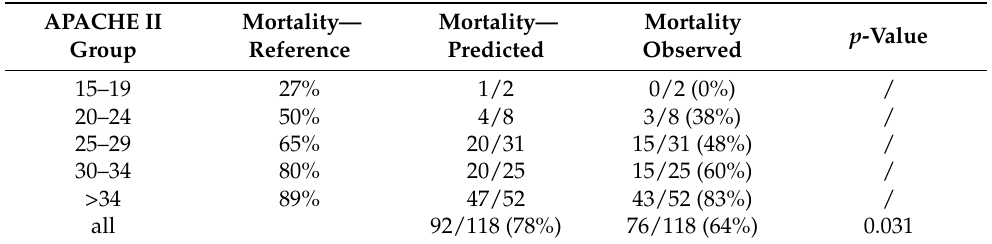
Table 6. APACHE II score, observed in-hospital mortality vs. predicted mortality rate. Comparison by Chi-squared